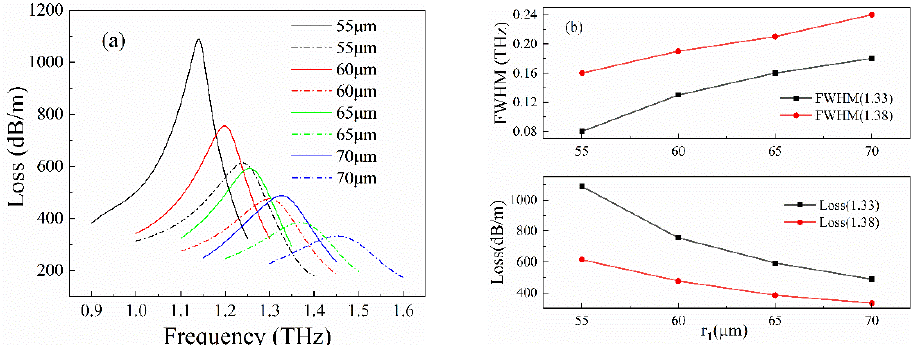
Figure 2. ( a ) Loss peak curves of different r 1 , solid line (the RI of bioanalyte is 1.33) and dashed line (the RI of bioanalyte is 1.38). ( b ) FWHM and loss of different r 1 .